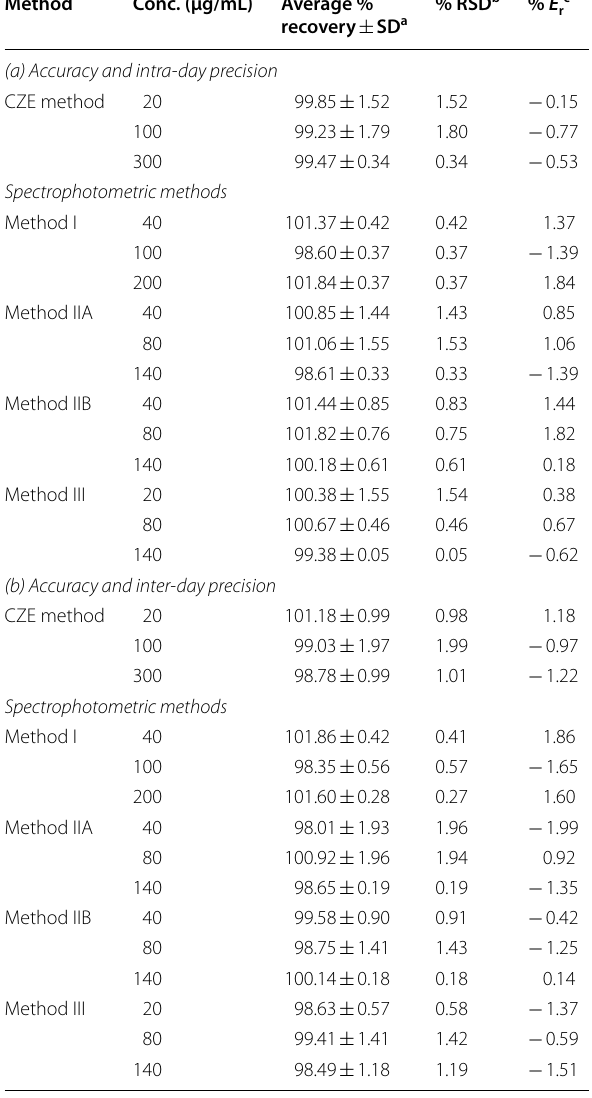
Table 3 Intra‑day and inter‑day precision and accuracy for the determination of TIG in intravenous infusion solution using the proposed